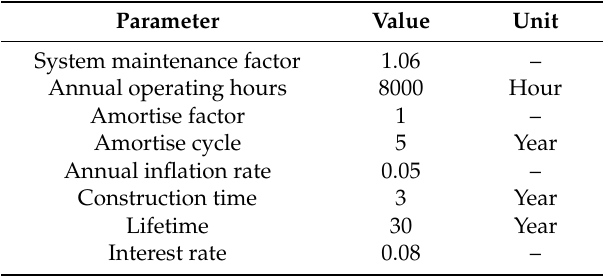
Table 5. Economic parameters of the coal-fired power plant subsystem.